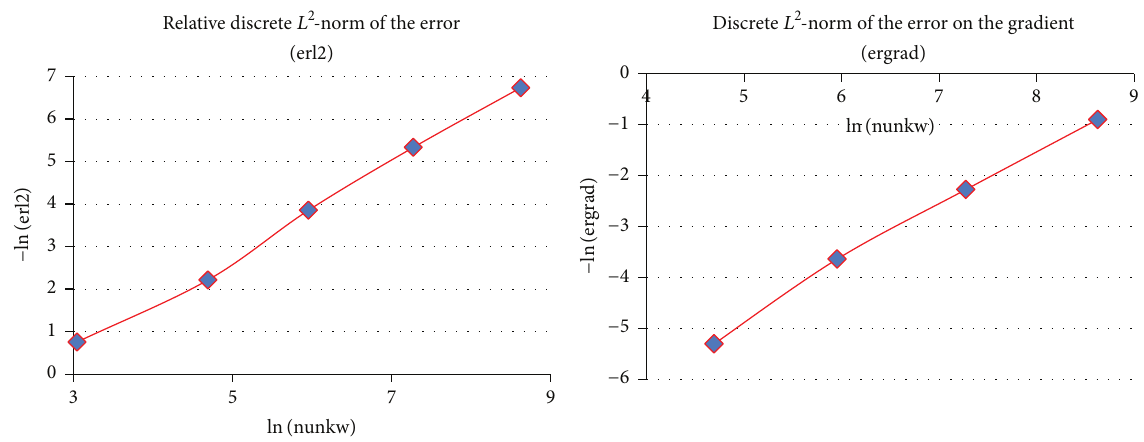
Figure 8: Relative discrete 𝐿 2 -norm of the error (erl2) and of the error on the gradient